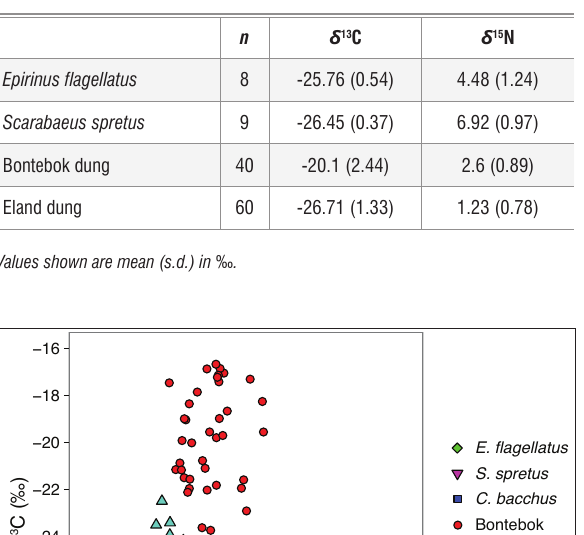
Isotope analyses of dung beetles and dung from Potberg